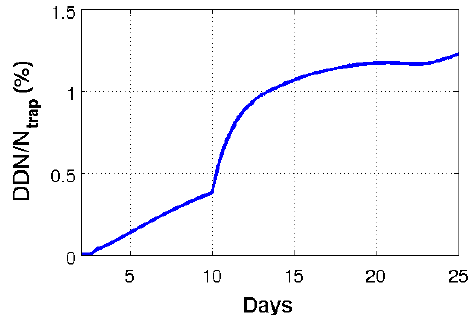
Figure 8. Patterns of change over time of the nitrogen fixation con- tribution (%) to particulate matter export in SIM E